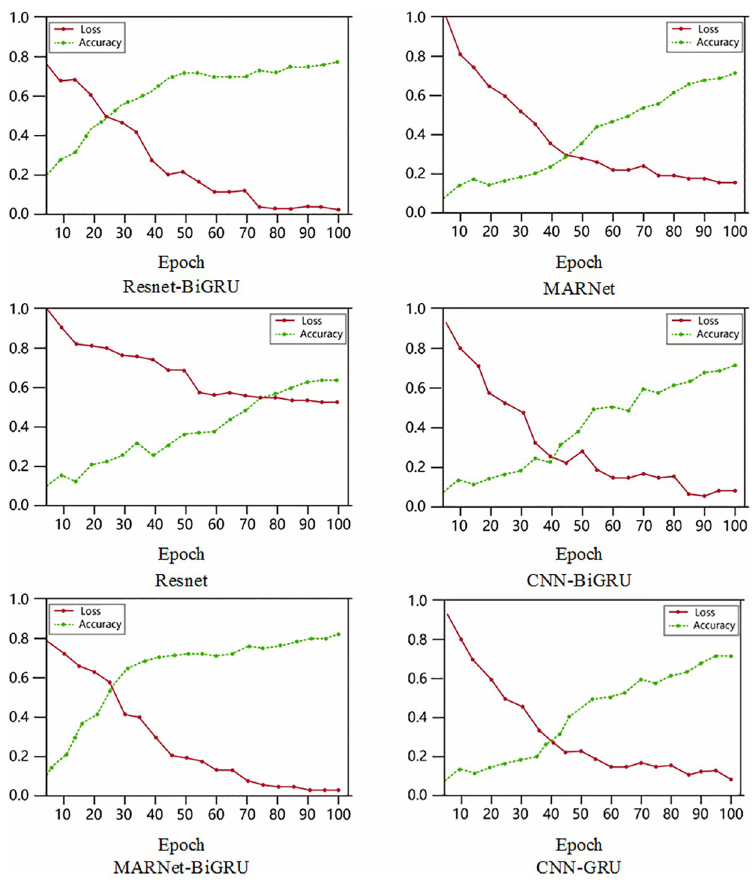
Fig 8. On the Sleep-EDF dataset, training accuracy and loss value under different algorithms.